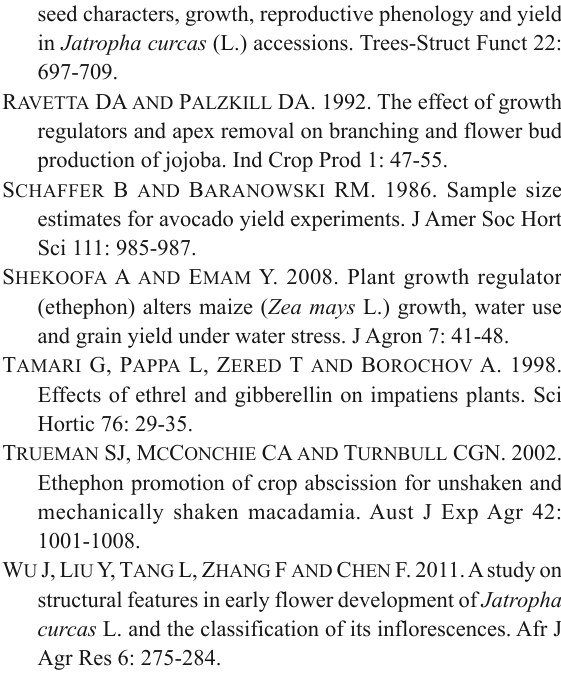
TABLE SI - Effects of ethephon (Florel ® ) concentrations on growth and reproductive variables (mean + SD) of Jatropha curcas L. plants with leaves and plants without leaves. † Test of statistical interactions between ethephon concentrations (C) and leaves (L) for each plant variable according to a two-way